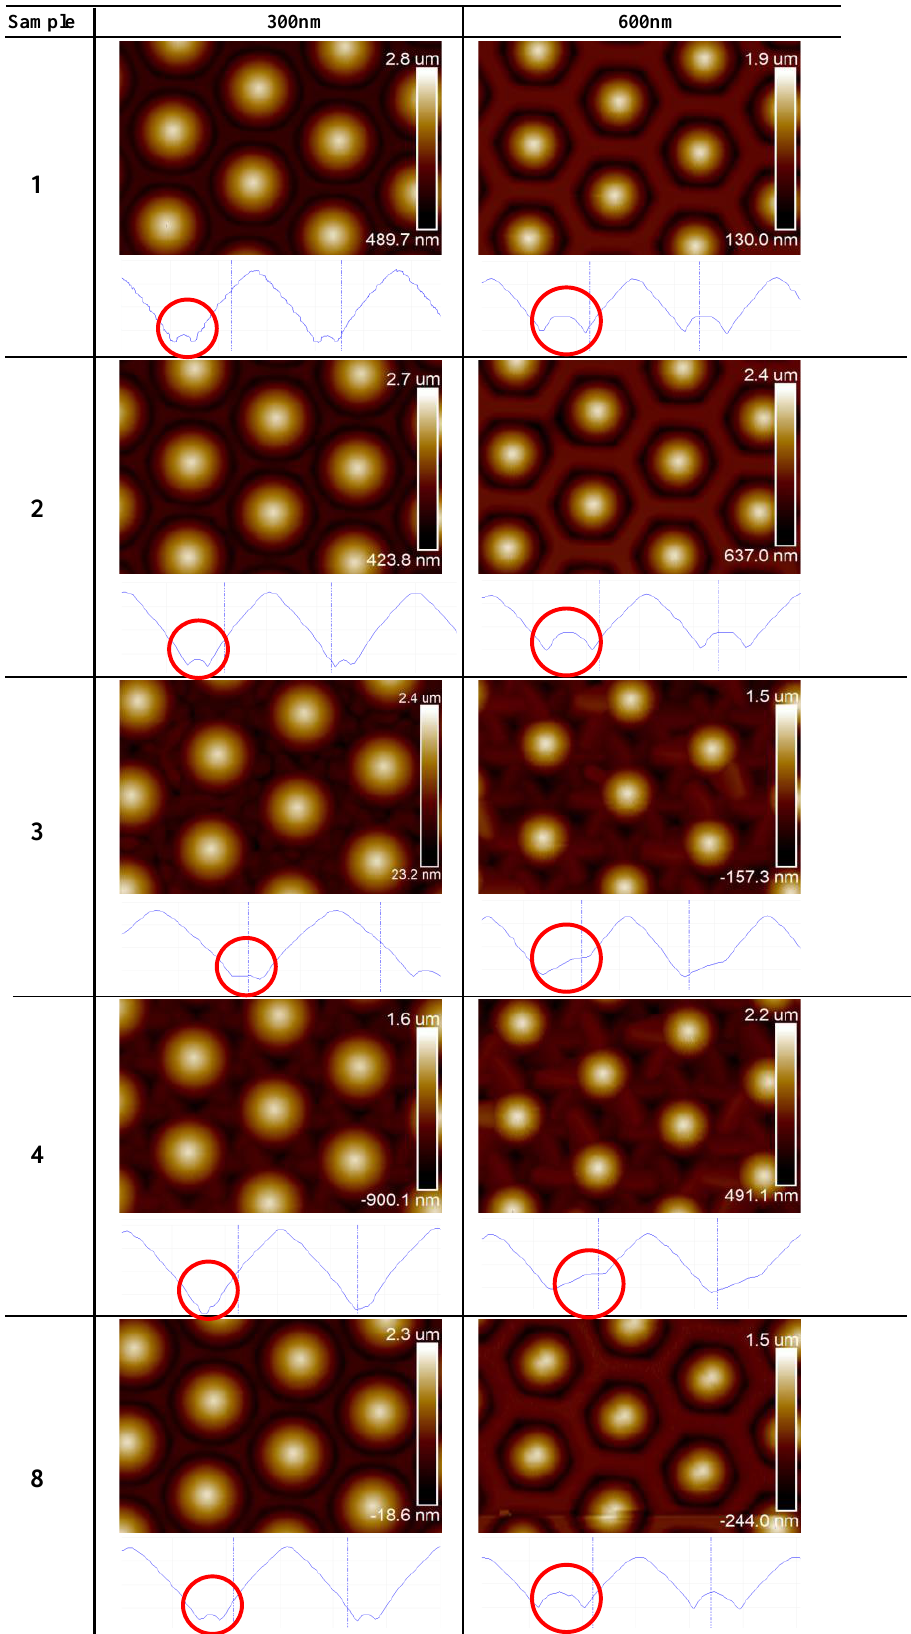
Figure 2. The samples contain different AC powers used in nitridation process of PVD recorded by the AFM vertical views and sections. The most evident distinctions occurred at the pedestals of the patterns pointed out by the red